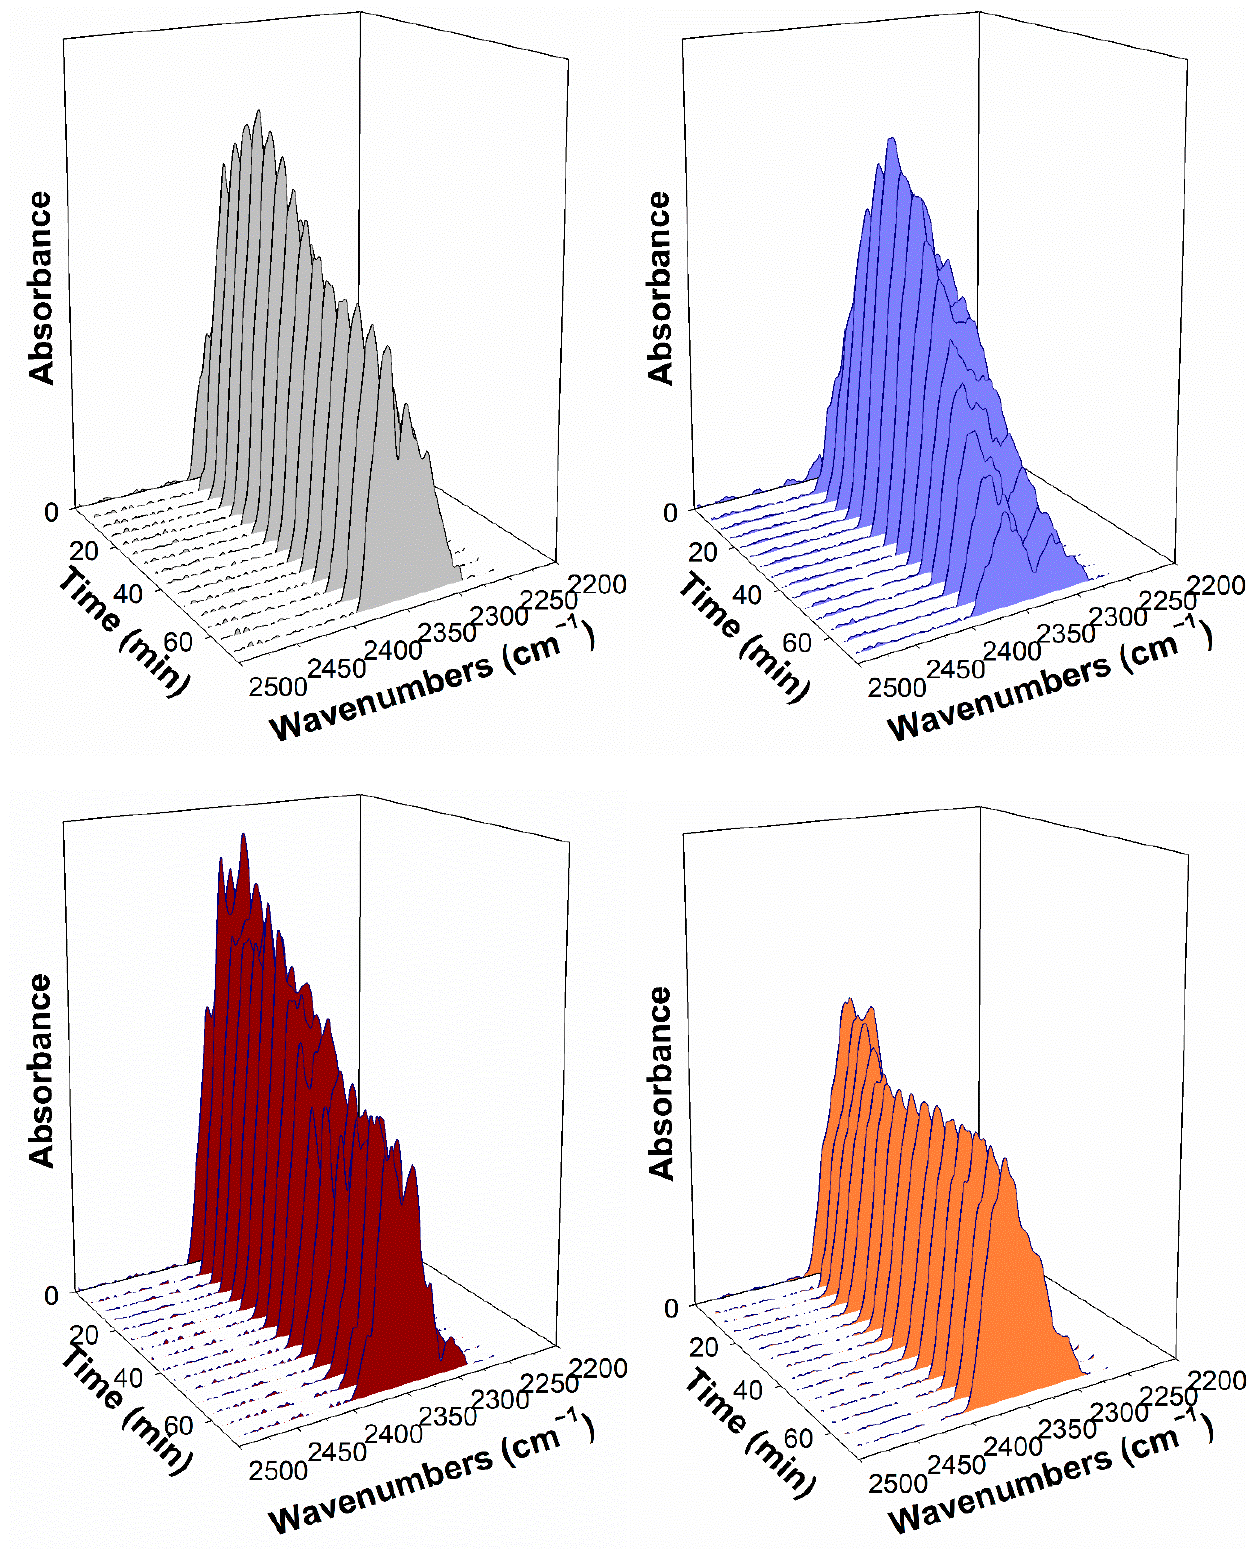
Figure 17. Where possible, response of the CO 2 gas phase band in steam at 130 ◦ C, including ( gray ) 2%Pt/ZrO 2 , ( periwinkle ) 0.55%Rb-2%PtZrO 2 , ( dark red ) 4.65%Rb-2%Pt/ZrO 2 , and ( orange ) 5.58%Rb-2%Pt/ZrO 2 . DRIFTS spectra before and after formate decomposition in steam are shown in Fig- ure 18. For all catalysts except 9.29%Rb-2%Pt/ZrO 2 , formate decomposes completely, as seen through the loss of ν (CH) at 2800–2900 cm − 1 , ν (OCO) sy at 1250–1450 cm − 1 , and ν (OCO) asy at 1500–1700 cm − 1 . Additionally, catalysts loaded with 1.86%Rb or greater show complete loss of the Pt-CO band at 1800–2100cm − 1 . After formate decomposition, the CO 2 precursor, adsorbed carbonate, persists with similar ν (OCO) bands to those of